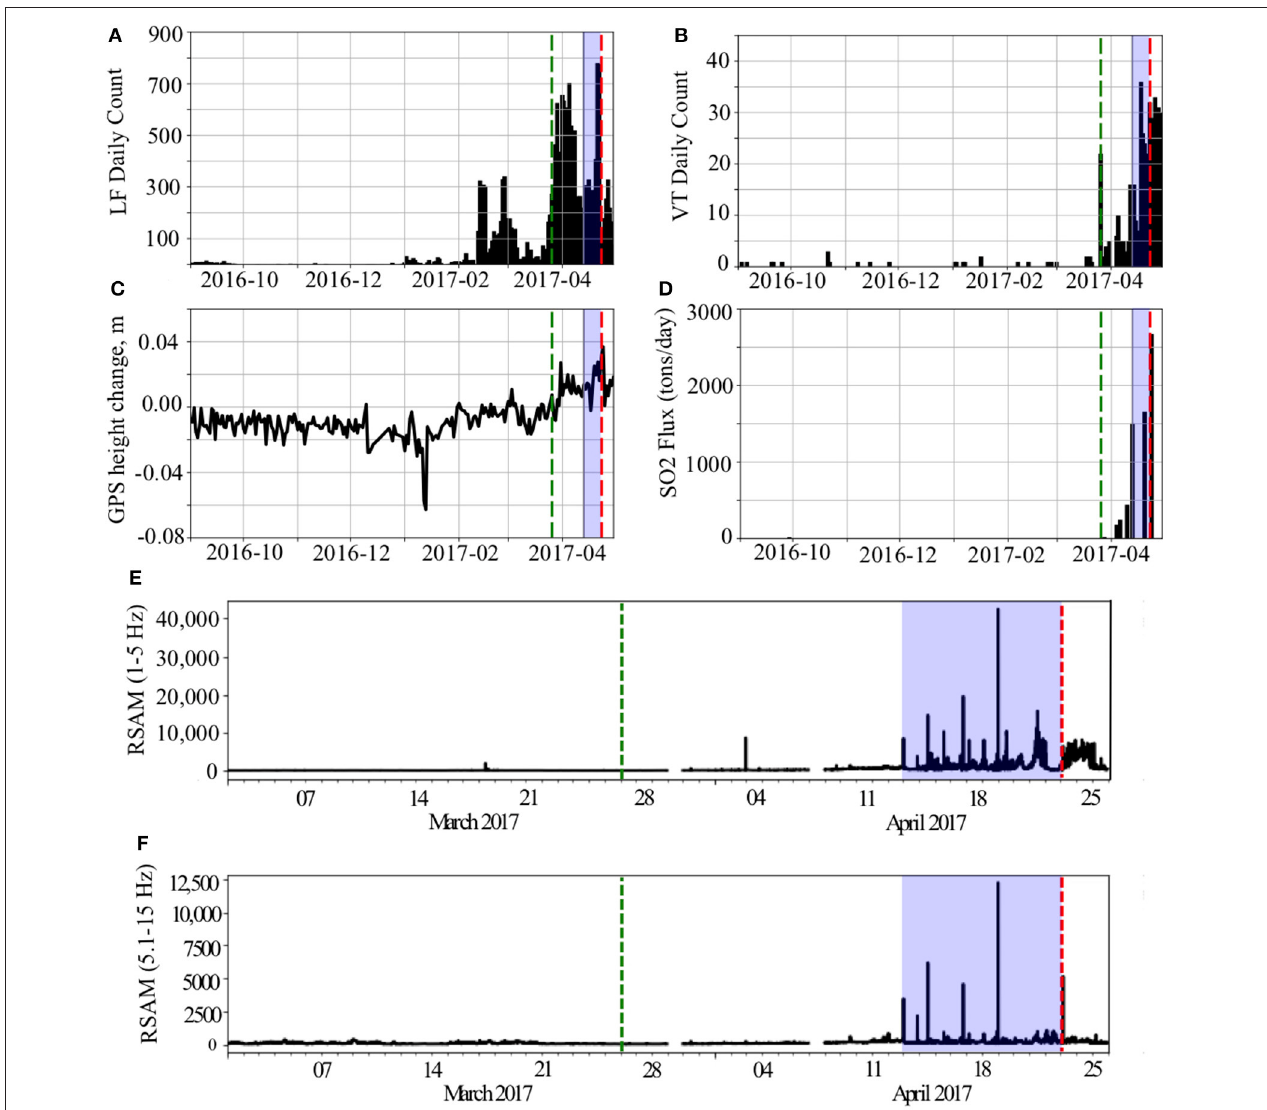
FIGURE 3 | Time series of monitoring data at Poás from September 2016 to 30 April 2017. The green dashed line indicates the timing of the VT swarm on 26 March 2017; the light blue shaded areas indicate the timing of phreatic and phreatomagmatic eruptions from 12 April onward; the red dashed line indicates the timing of the large phreatomagmatic eruption on 23 April at 04:12 UTC. (A) Daily counts of LF (low frequency) seismicity. The daily counts in February and early March were not considered unusual. (B) Daily counts of VT (high frequency) seismicity. Very few seismic events were identified before March 2017. The VT swarm on 26 March is clearly visible (green dashed line). (C) GPS height change in meters (vertical component, station VPEV). A clear inflation of 4–5 cm can be observed from early March to 23 April. The large deflation signal in January 2017 is considered to be an outlier, as measurements returned to what was considered background levels the next day. (D) SO 2 flux, measured by walking a transect along the western crater rim. (E) 10 min filtered RSAM (1–5 Hz) recorded at station VPVF, 1 March to 30 April 2017. (F) 10 min filtered (5.1–15 Hz) RSAM recorded at station VPVF, 1 March to 30 April